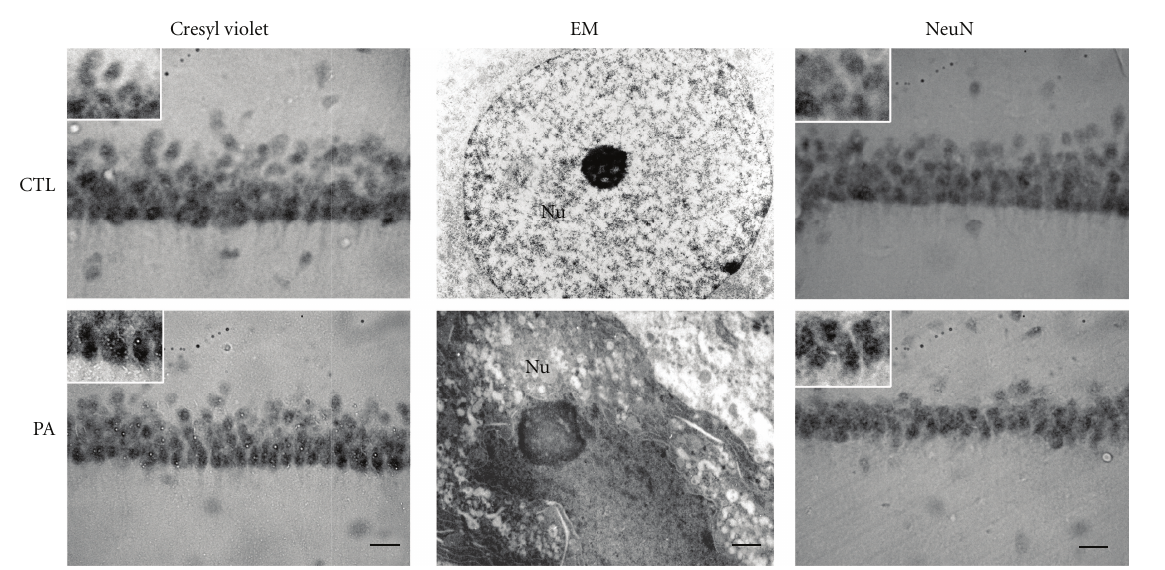
Figure 1: Micrographs of Stratum radiatum of CA1 hippocampal area from 4-month-old control rats and rats subjected to 19min of PA. Vibratome sections of 50 μ m were cut and stained with cresyl violet ( Left ), analysed by electron microscopy (EM) ( Middle ) and NeuN immunostaining ( Right ). A clear nuclear condensation was observed after 19 min of PA. Electron micrograph showed that most of the condensed cells correspond to neurons in degeneration. Abnormal NeuN+ nuclei were increased in asphyctic animals respect to control group. Scale bar: 30 μ m and 0.5 μ m for EM. Nu: